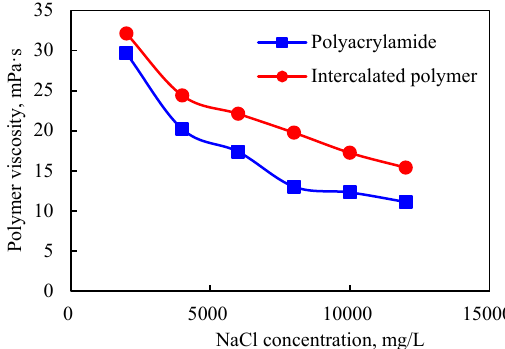
Figure 11. Salt resistance of the intercalated polymer.